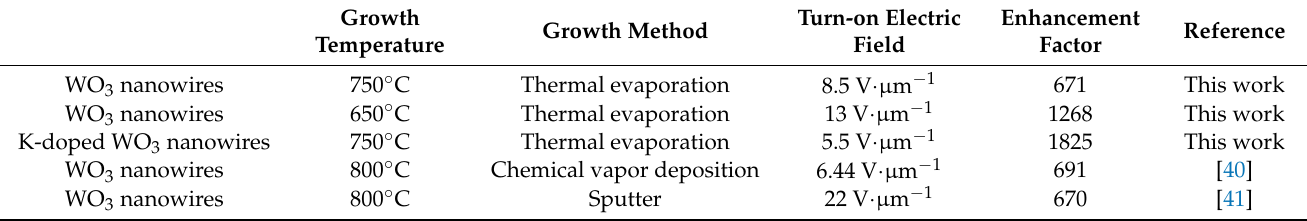
Table 1. Comparison of the field emission properties of WO 3 nanowires with previous